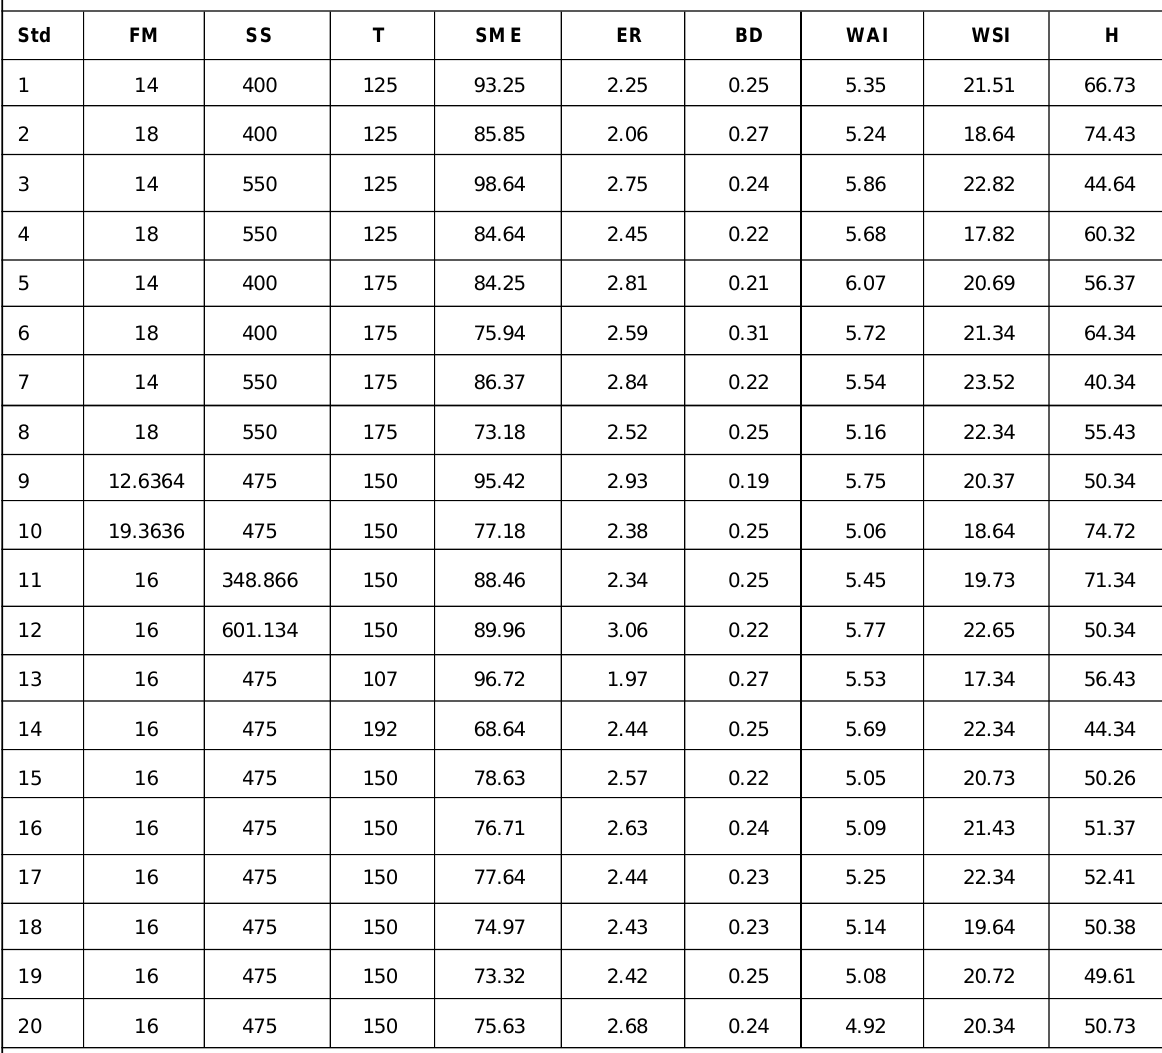
Table 2: Effect of extrusion condition on product responses Std FM